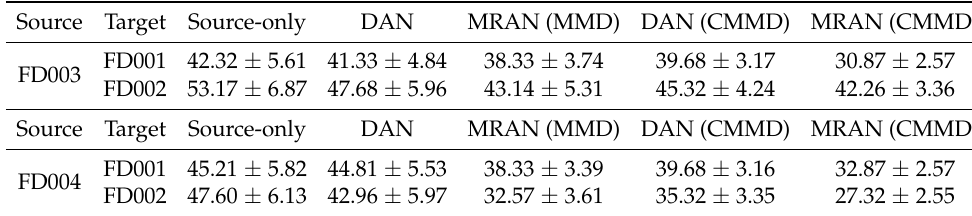
Table 4. RMSE in different MRAN.